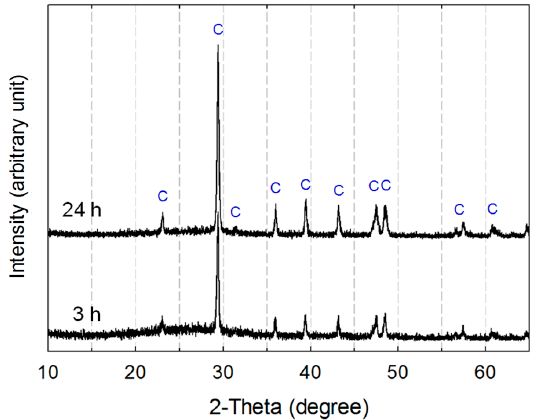
Figure 13. XRD patterns of the carbonated product in the presence of dissolved silica.